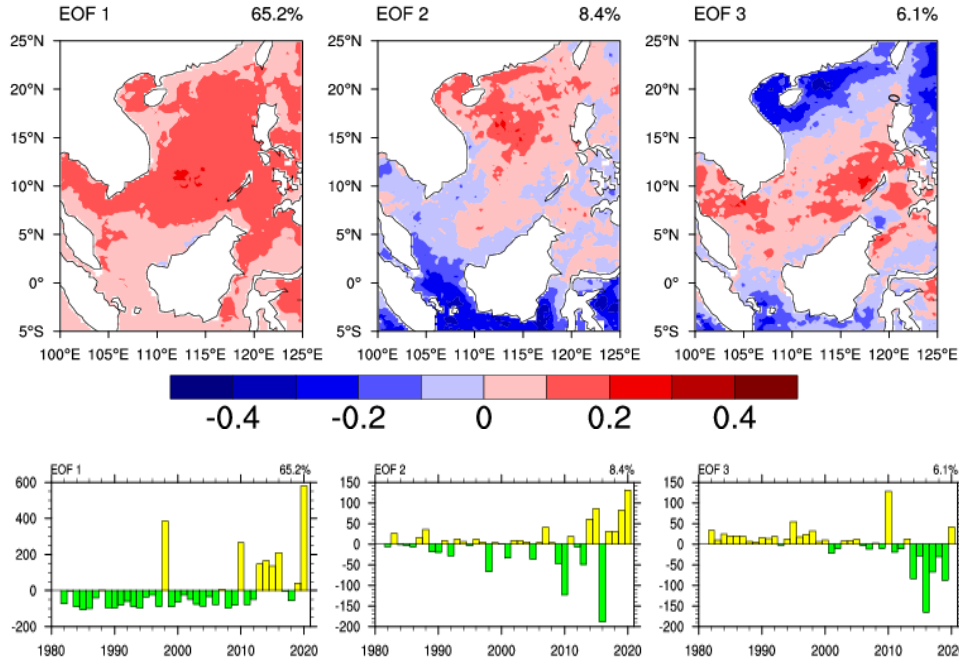
Figure 4. Same as in Figure 3, but for the MHW duration.